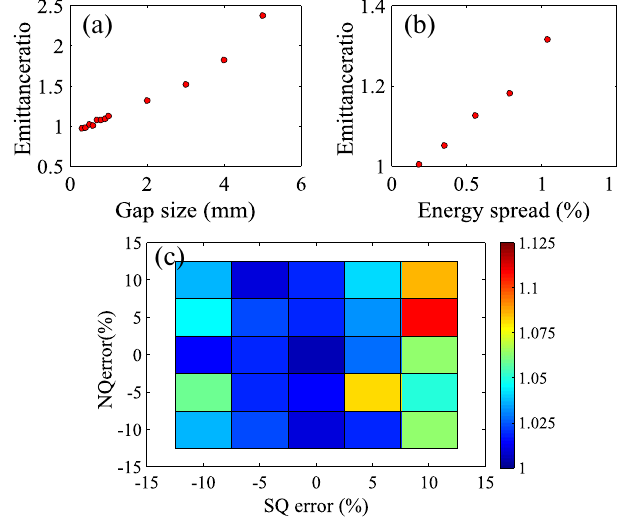
FIG. 3. Top row: ratio of measured emittance to the emittance after the horizontal slit as a function of the (a) vertical gap size and (b) energy spread. Bottom: emittance ratio for different quadrupole strength errors on the skew and the normal quadru- poles. Colors correspond to the emittance ratio. Ratios are estimated from start-to-end